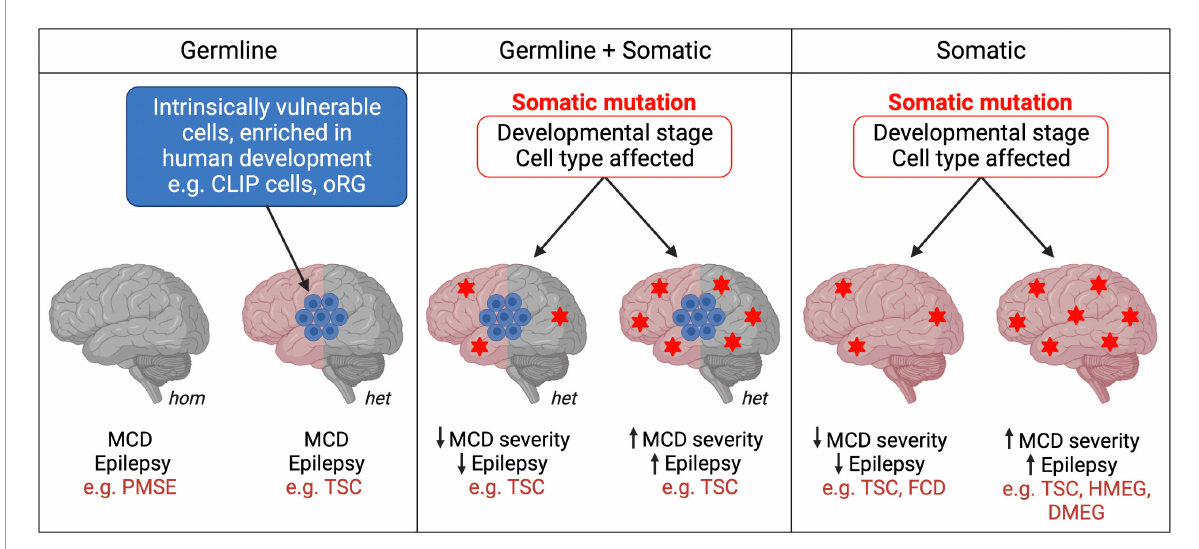
FIGURE2 Germline and somatic mutations in mTORopathies. mTORopathies can arise from homozygous (hom) or heterozygous (het) germline mutations. In cell populations intrinsically vulnerable to mTORC1 hyperactivity during human neurodevelopment, heterozygous mutations could be sufficient to result in MCD (left panel). When somatic events follow a heterozygous germline mutation (e.g., second hits) (middle panel), or when they alone cause mTORopathies (right panel), the developmental stage and subset of cells affected might determine disease severity. Heterozygous Tsc1/2 mutations (left panel) may also be sufficient to cause cellular changes, perhaps at later stages of neuronal development and maturation, as reported in hiPSC models, which contribute to the neurological manifestations of